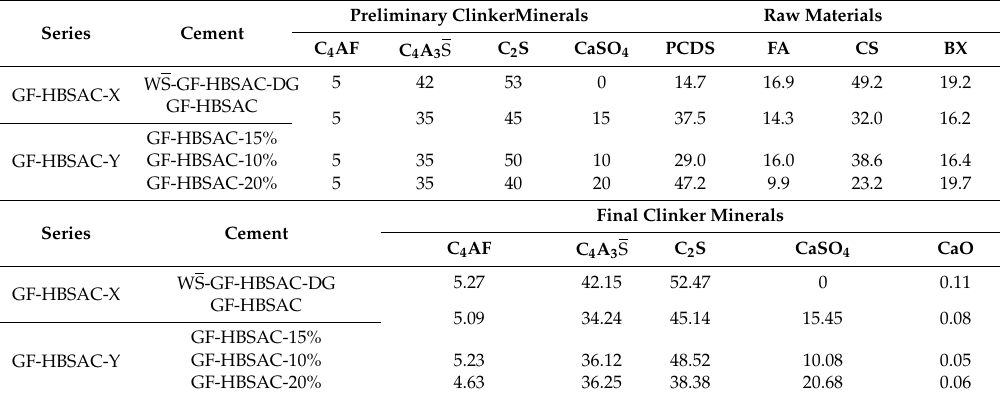
Table 2. Design of the mineral composition of the clinkers and the proportion of the raw materials, wt.%. Series